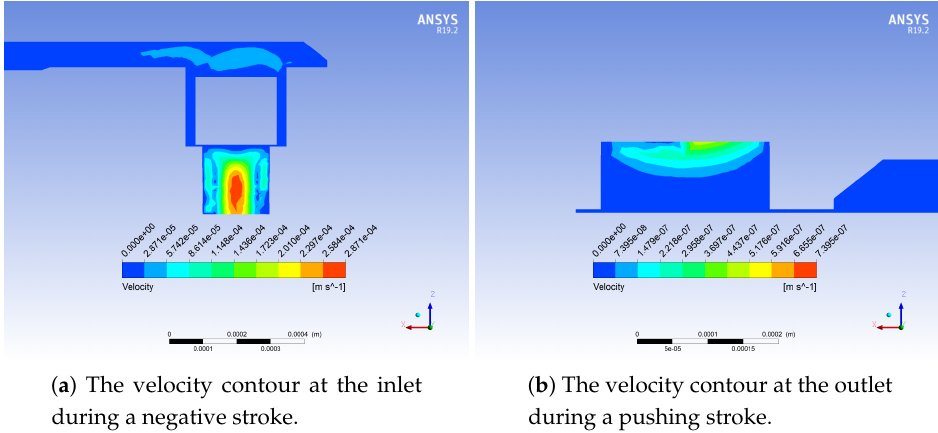
during a negative stroke. during a pushing stroke. Figure 18. Computed velocity contours at the inlet and outlet of the micropump [22].